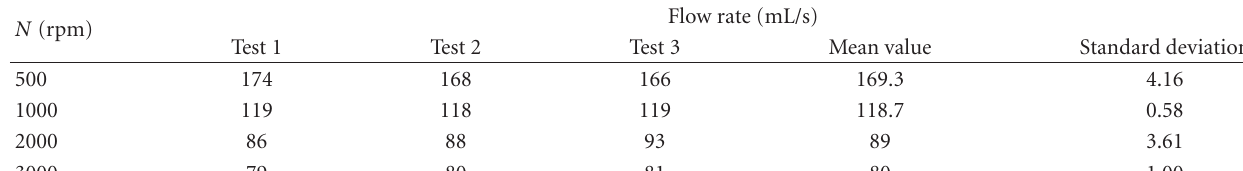
Table 2: Reliability of measurements.